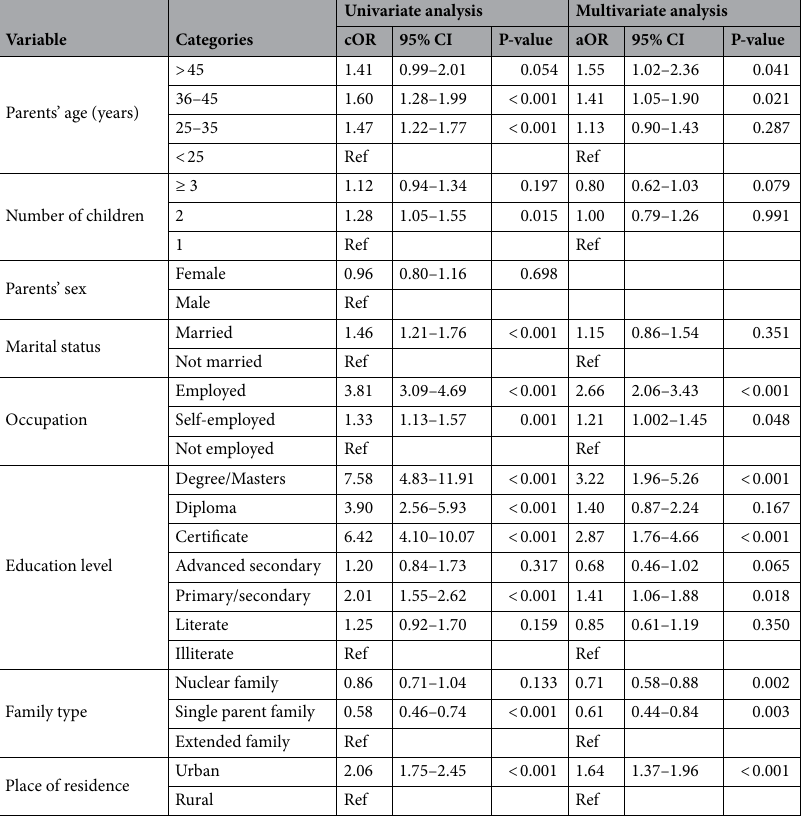
Table 4. Univariate and multivariate analysis of factors associated with parents’ good knowledge about antibiotics use in children. cOR crude odds ratio, aOR adjusted odds ratio, 95%CI 95% confidence interval, Ref reference